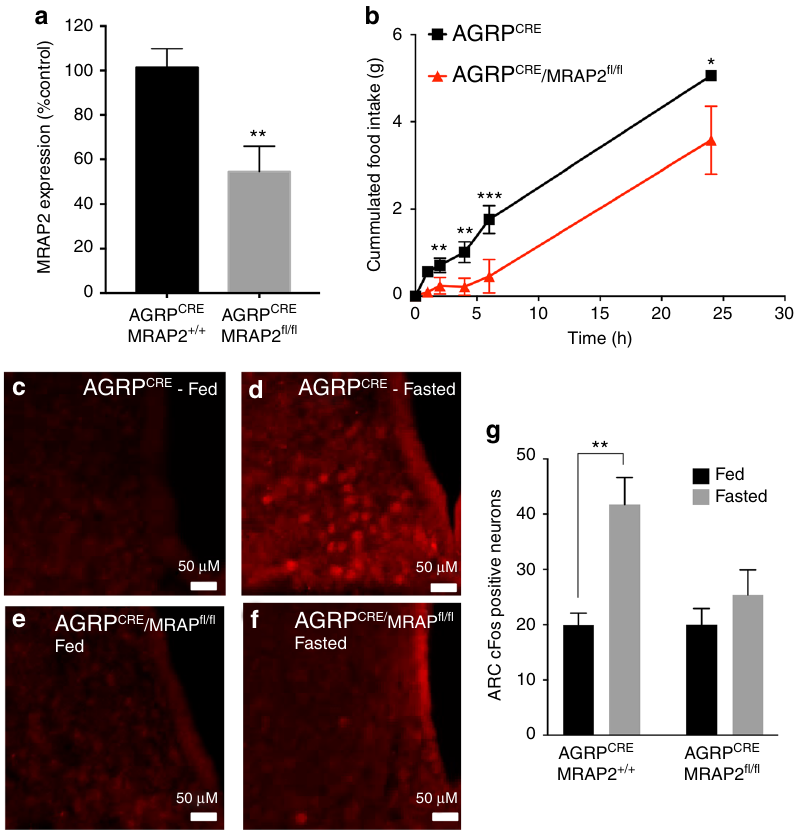
Fig. 3 MRAP2 is important within AGRP neurons for starvation sensing. a qPCR measurement of MRAP2 expression in the ARC of AGRP CRE /MRAP2 +/+ and AGRP CRE /MRAP2 fl / fl mice. b Food intake after a 24 h fast in AGRP CRE /MRAP2 +/+ and AGRP CRE /MRAP2 fl / fl mice ( n = 8 AGRP CRE /MRAP2 +/+ , n = 5 AGRP CRE /MRAP2 fl / fl ). c – f Immuno fl uorescent detection of cFos expression in the arcuate nucleus of fed or fasted AGRP CRE /MRAP2 +/+ and AGRP CRE /MRAP2 fl / fl mice. g Quanti fi cation of fasting-induced cFos expression in the arcuate nucleus of AGRP CRE /MRAP2 +/+ and AGRP CRE /MRAP2 fl / fl mice ( n = 3/group). Error bars are SEM. *** p < 0.001, ** p < 0.01, * p <